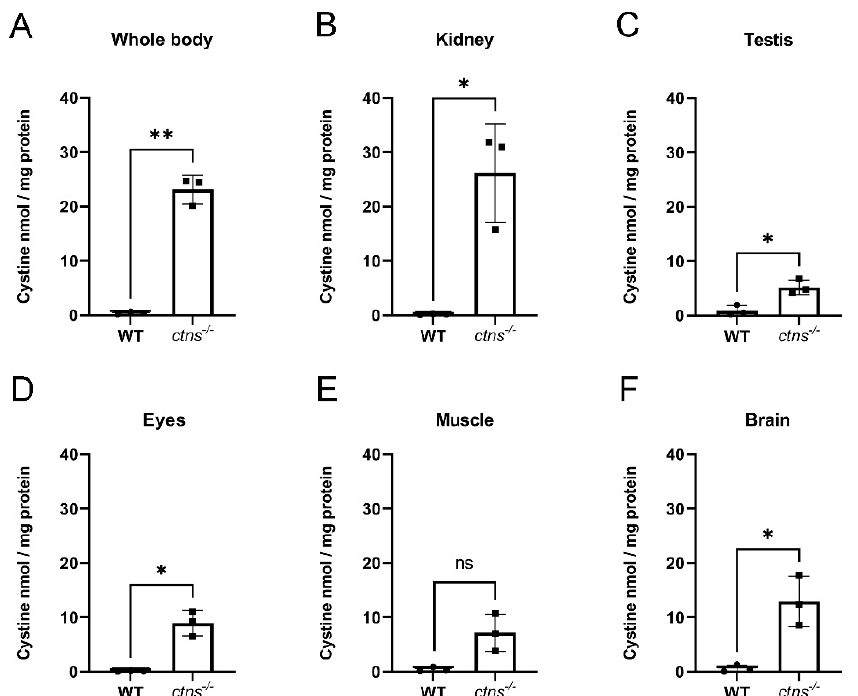
Figure 1. Cystine content in homogenates of wild-type and ctns − / − zebrafish. ( A – F ) Cystine content in whole body ( A ), kidney ( B ), testis ( C ), eyes ( D ), muscle ( E ) and brain ( F ) in wild-type and ctns − / − 18-month-old male zebrafish. Cystine concentration is expressed as nmol/mg protein. Each dot represents one zebrafish, for a total of n = 3 wild-type and n = 3 ctns − / − 18-month-old male zebrafish; unpaired t test with Welch’s correction, two tailed: * p < 0.05; ** p <0.01; ns: not significant.